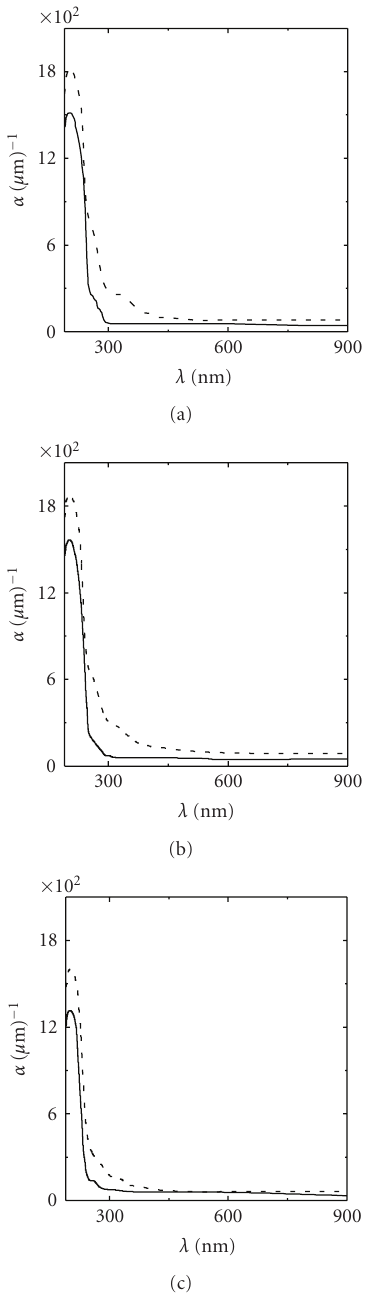
Figure 3: Absorption spectrum of (a) pure PMMA, (b) blend of (50/50 PMMA/PVAc), and (c) pure PVAc before (—) and after (- - -) exposure to UV radiation for 24